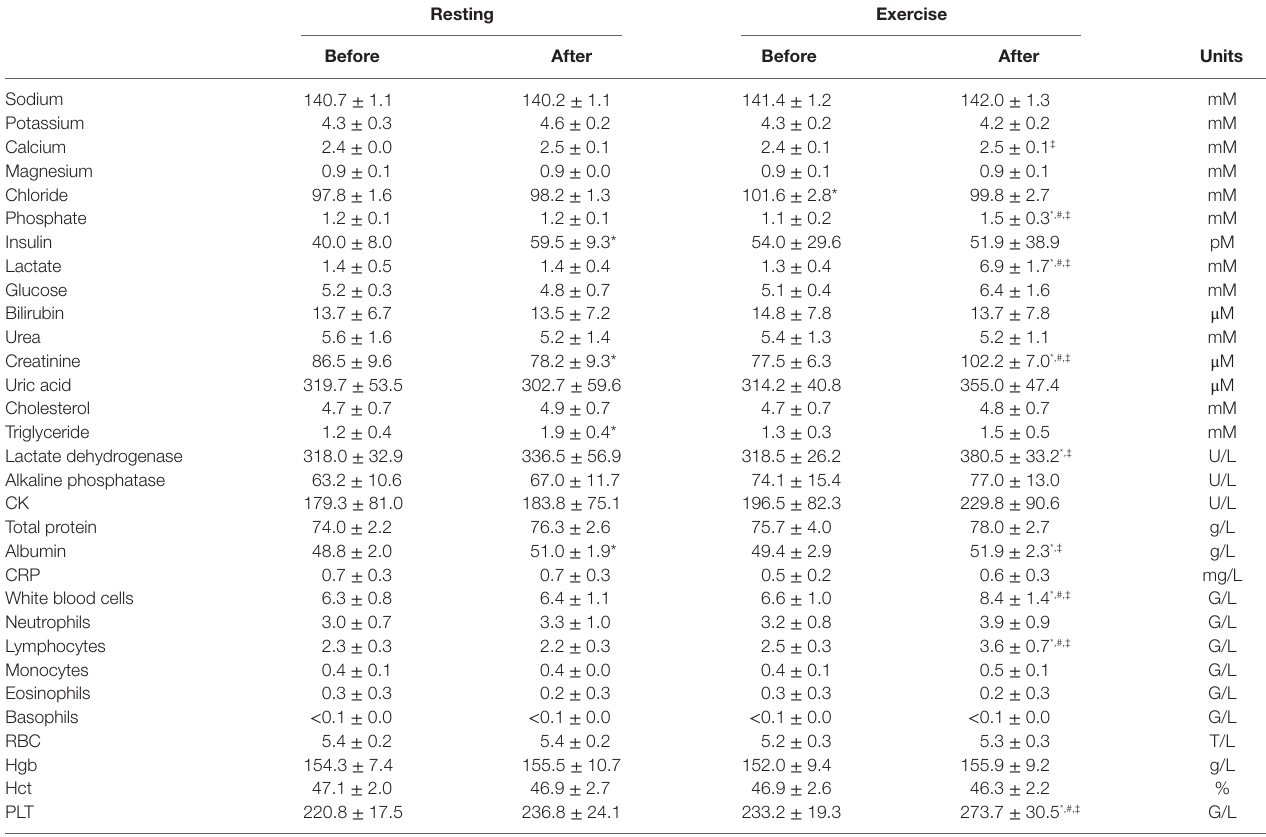
TaBle 2 | Serum biochemical and blood cell parameters before and after exercise or resting. resting exercise Before after Before after